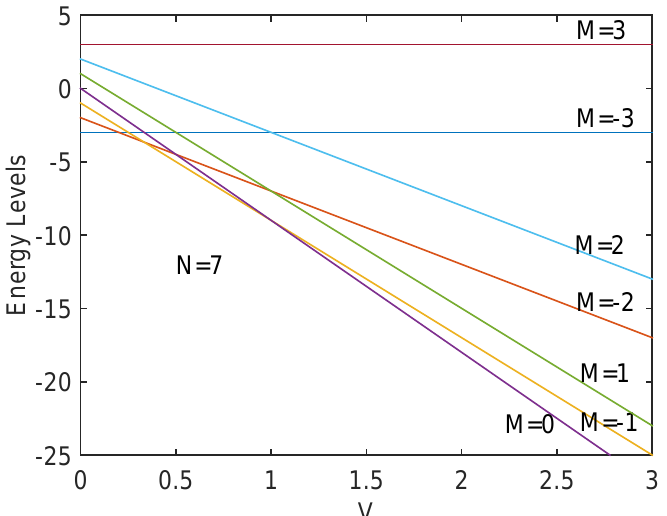
Figure 3. Model-energy levels versus coupling constant V for N = 7 fermions. Energies are re- normalized so that the one for the ground state equals zero always. Characterization of levels is like in Figure 2. It is clearly seen that, as V grows, the energetic distance between the ground state and all the excited states steadily